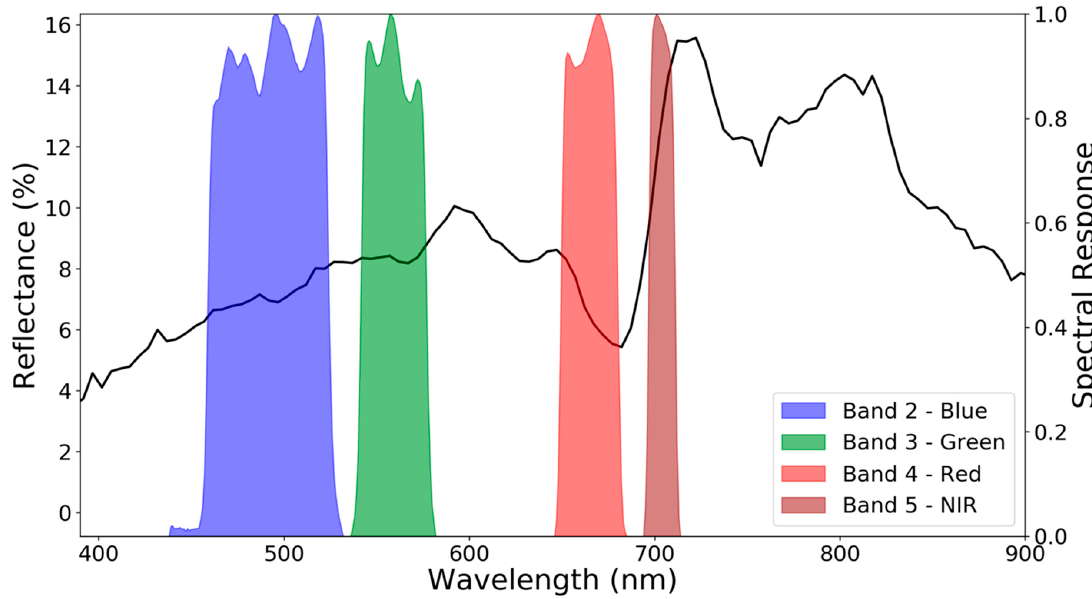
Figure 2. Sentinel-2B spectral response curves used for calculation of the 4-band dataset derived from VSWIR imaging spectrometer data. An example Global Airborne Observatory VSWIR spectrum from 1-m deep water is given for reference. The broad bands from multi-spectral sensors average over spectral feature information.